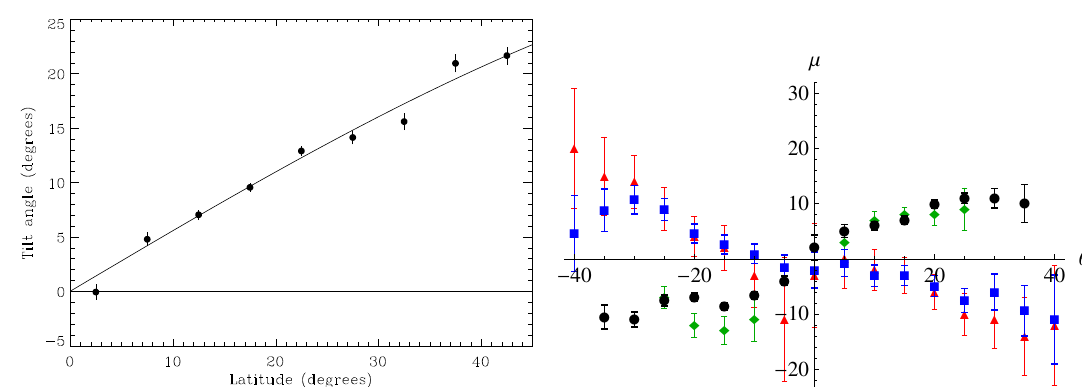
Figure 8: Latitude-dependence of tilt angles determined more recently. Left: Tilt angle of 160 079 bipolar regions (bipolar active regions were identified in each magnetogram independently, so one specific bipolar region was included several times in the dataset) by Stenflo and Kosovichev (2012); image reproduced with permission, copyright by AAS. SOHO/MDI magnetograms were used for a 15 year period between May 1996 – April 2011. Tilt angles outside the range [–90 (cid:176) , +90 (cid:176) ] have been shifted by 180 (cid:176) to be brought back to this interval, to allow all regions to be described by a single relation, irrespective of hemisphere or cycle. Positive tilt angle 𝛾 means that the preceding polarity is equatorward of the following polarity. The solid curve is the fit function 𝛾 = 32 . 1 ∘ sin 𝑏 , where 𝑏 is the heliographic latitude. Right: Bipole tilt angles for small and large bipoles as well as for the north and south hemispheres determined separately using SOHO/MDI and SDO/HMI data. Image reproduced with permission from Tlatov et al. (2013), copyright by the authors. Black squares correspond to areas 𝑆 > 300 MSH for MDI, green diamonds to areas 𝑆 > 300 MSH for HMI. Blue points correspond to areas 50 < 𝑆 < 300 MSH for MDI, red triangles to areas 20 < 𝑆 < 100 MSH for HMI. 𝐵 min = 10 G for MDI and 15 G for HMI. The tilt angles are the opposite for small bipoles than that for large ones, which conform to Joy’s